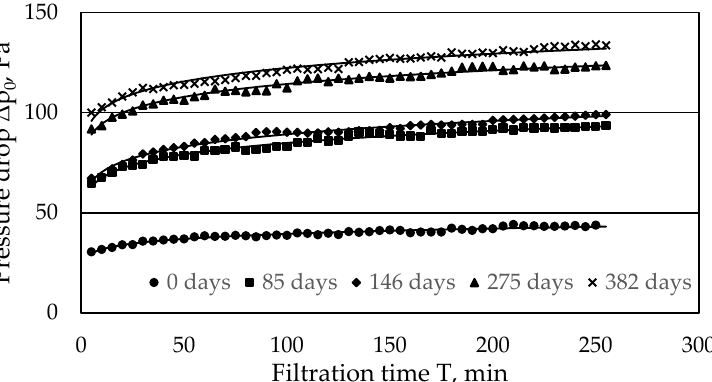
Figure 4. Airflow resistance through the filter fleece before the regeneration impulse for the bags used in the tests. Service life of 0, 85, 146 and 275, and 382 days.